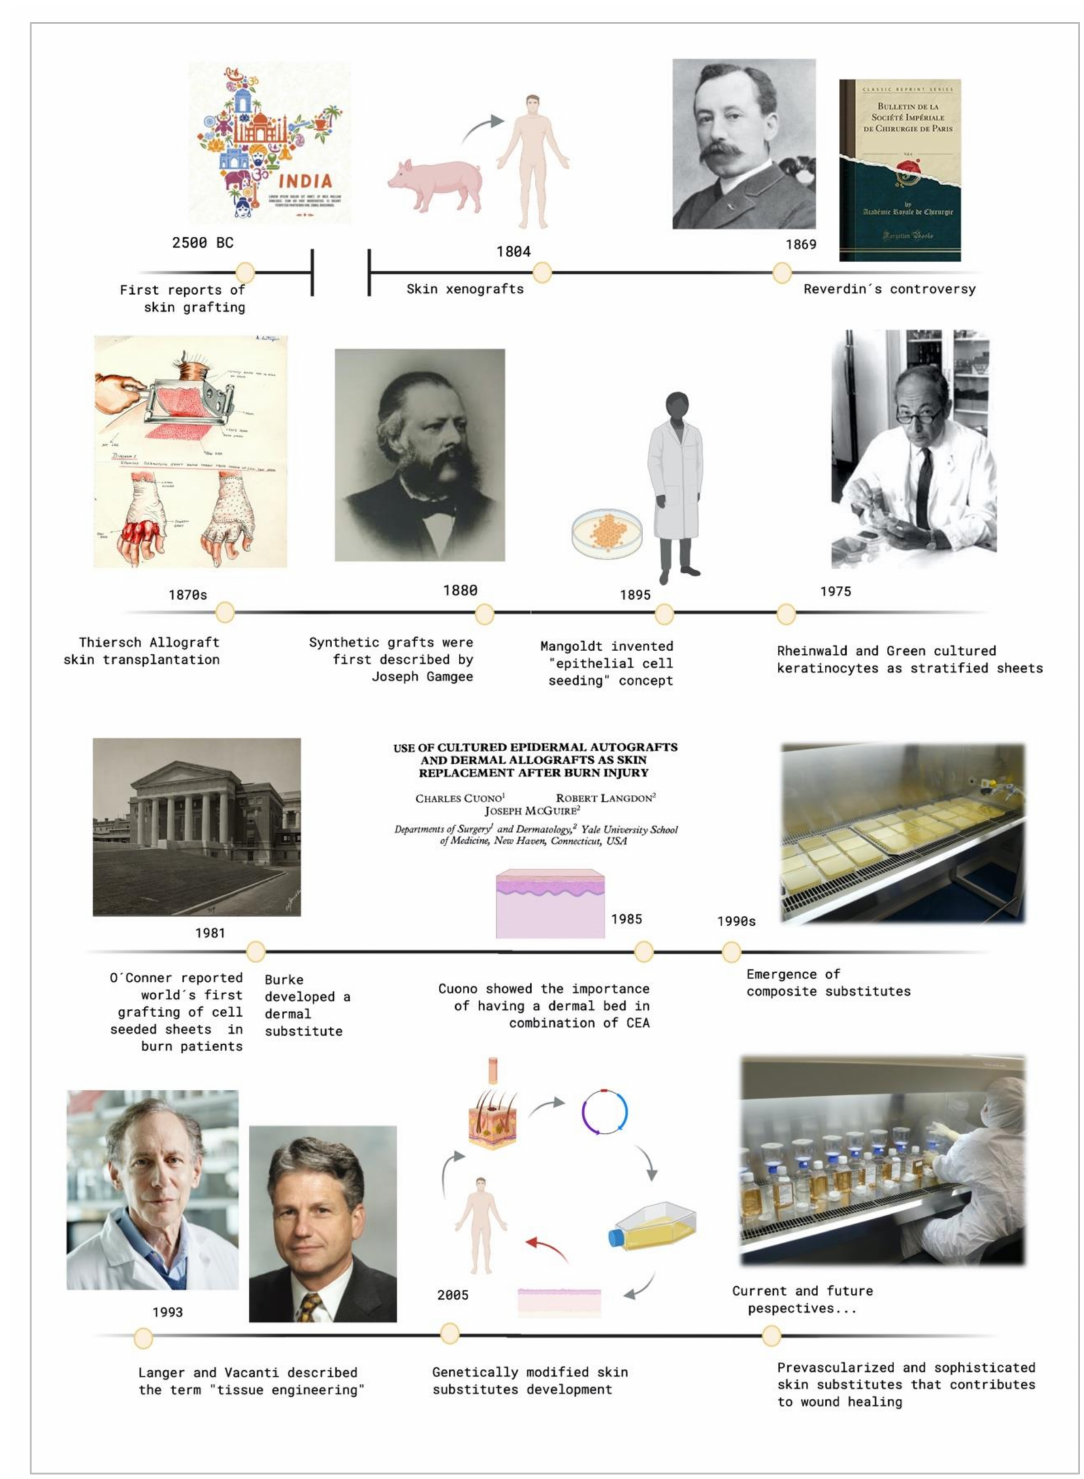
Figure1. Timelineofthecrucialeventsthatcontributedtotissueengineeringdevelopment. Createdwith